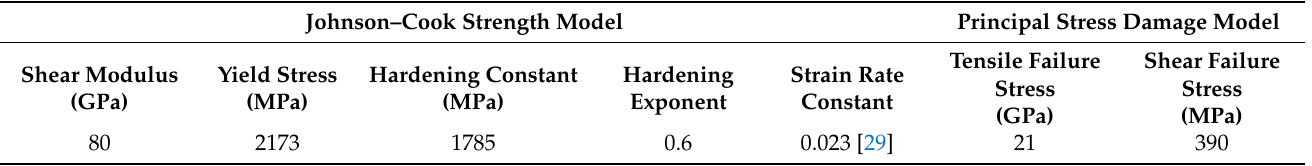
Table 3. Properties of the ball bearing material used in simulations.